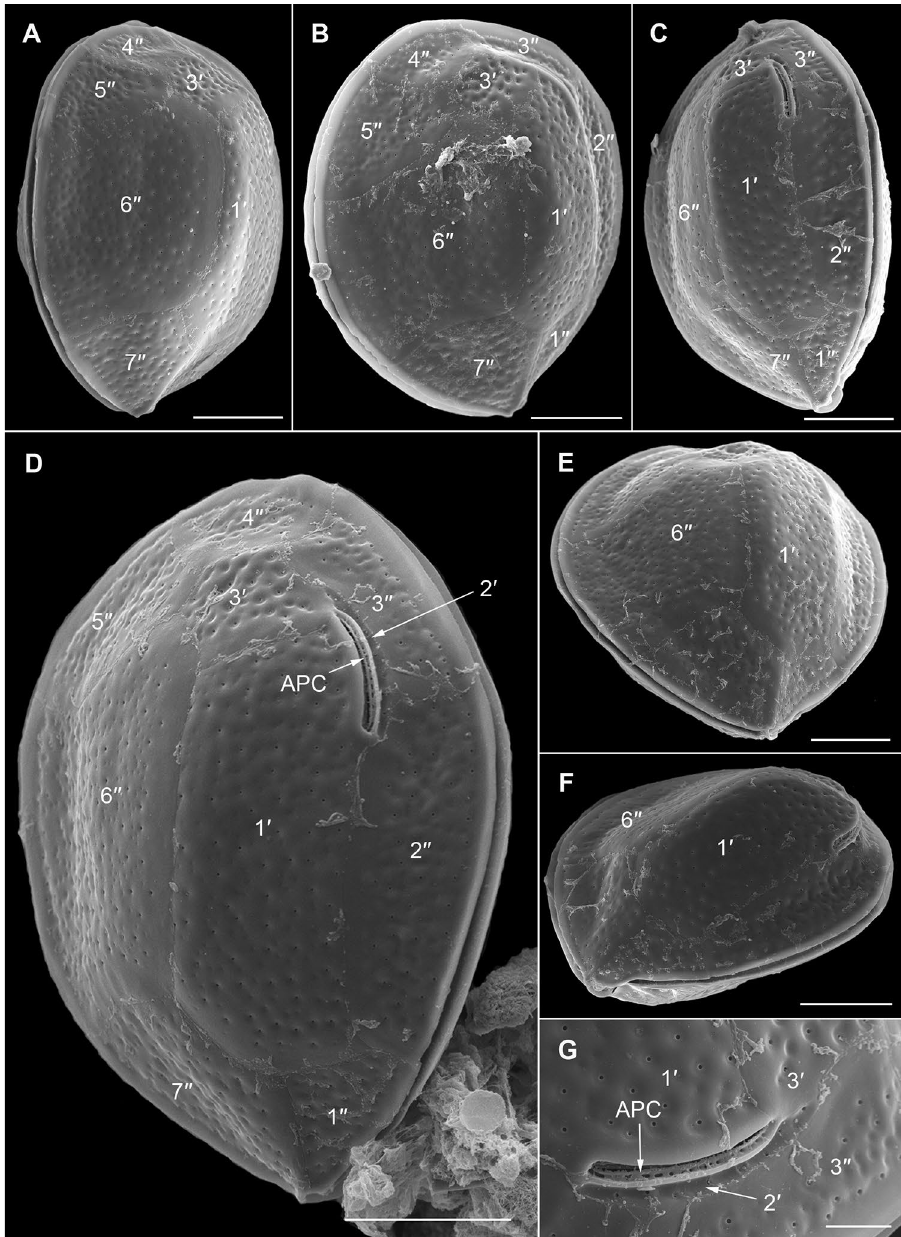
Figure. 6. Scanning electron micrographs of Ostreopsis lenticularis cells from field samples showing the epithecal tabulation. ( A ) Apical to right lateral view. ( B ) Apical view. ( C,D ) Apical to left lateral view. ( E ) Ventral to apical view. ( F ) Left lateral to ventral view. ( G ) Detail of the apical pore complex (APC). Scale bars = 20 µm, except G: 5